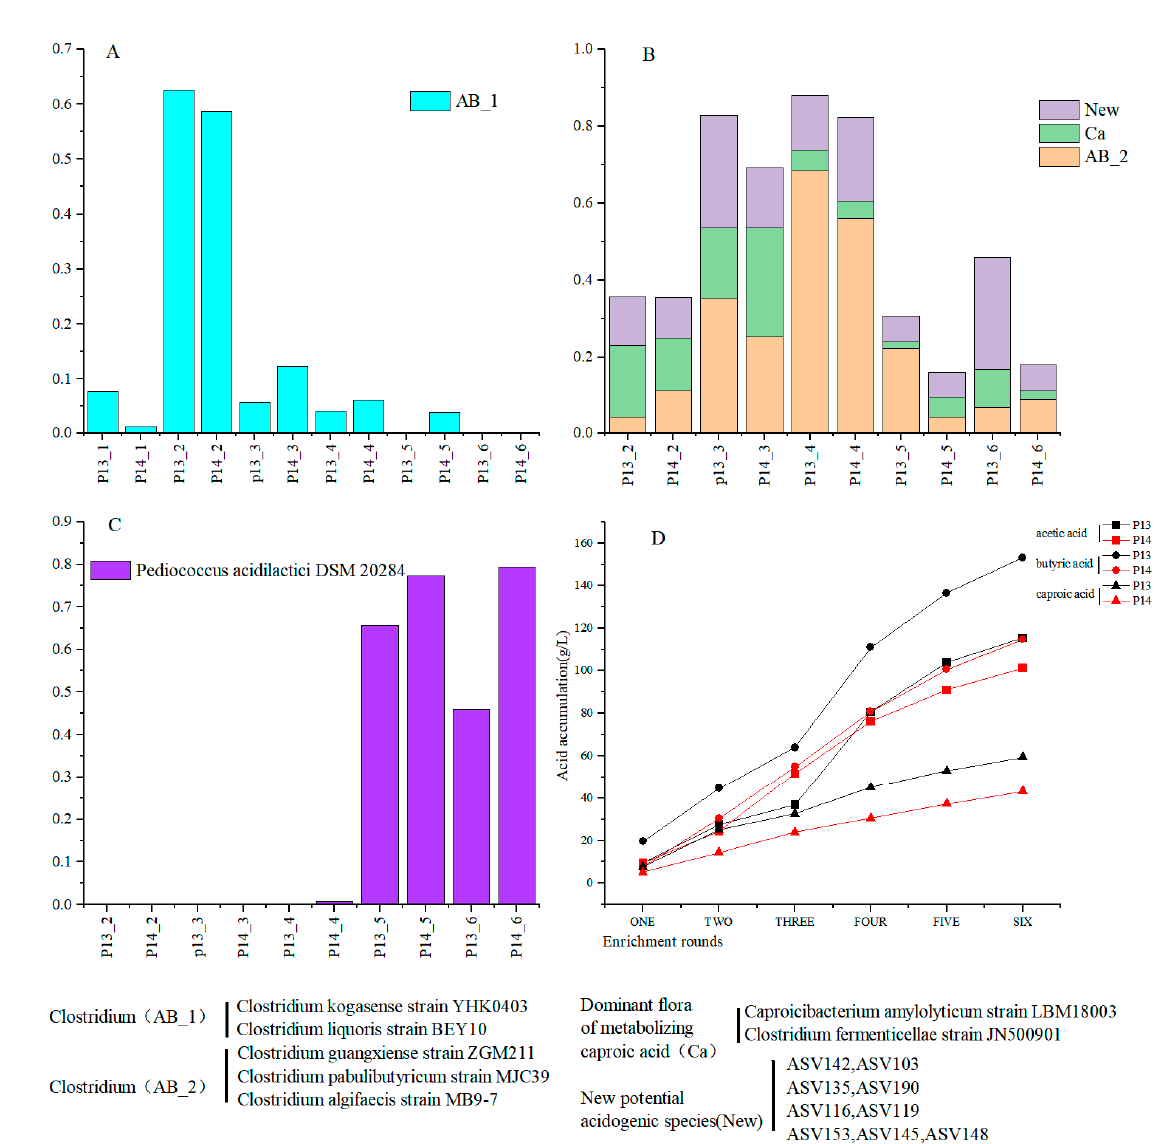
Figure 5. Changes in dominant microorganisms and acid accumulation in each period. ( A ) Changes in dominant acid-producing microorganisms in adaptation period. ( B ) Changes in dominant acid- producing microorganisms and potential new acid-producing species in main fermentation period.